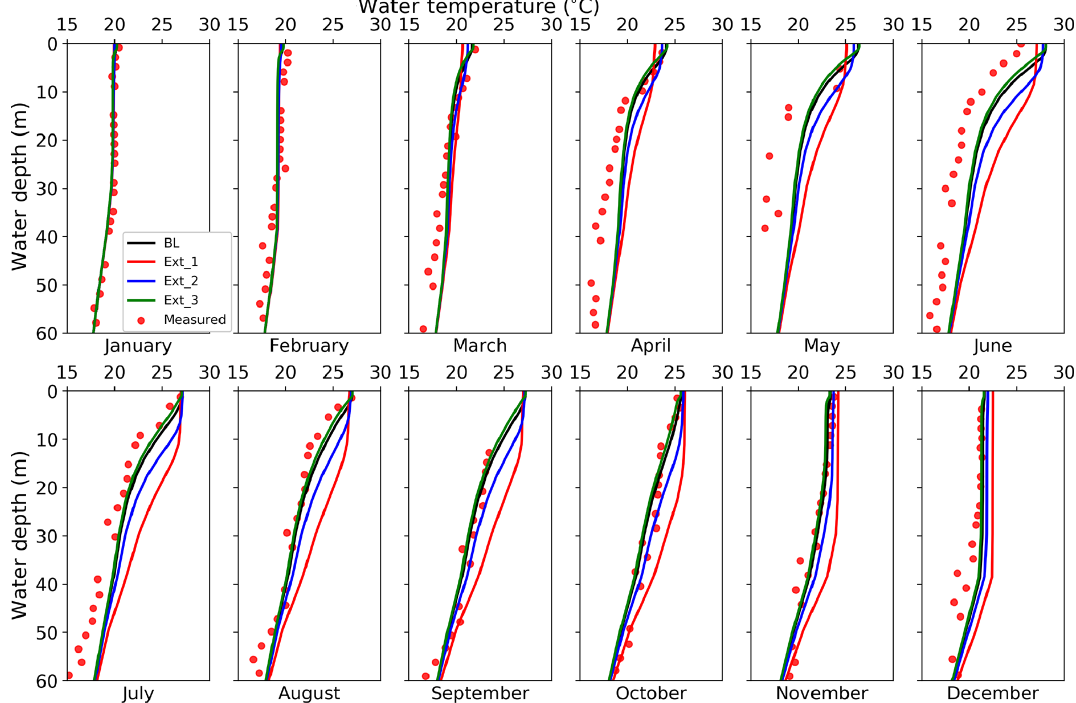
Figure 12. Monthly vertical temperature profile for the first 60m water by observation (red dots), BL (black line), Ext_1 (red line), Ext_2 (blue line), and Ext_3 (green line) in the year